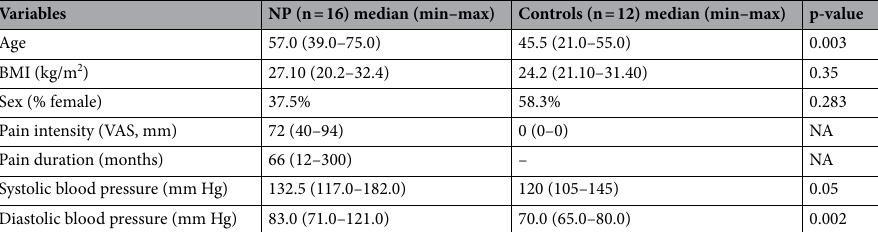
Table 2. Clinical variables for patients with neuropathic pain (NP) and healthy controls. VAS Visual Analogue Scale, NA not applicable.